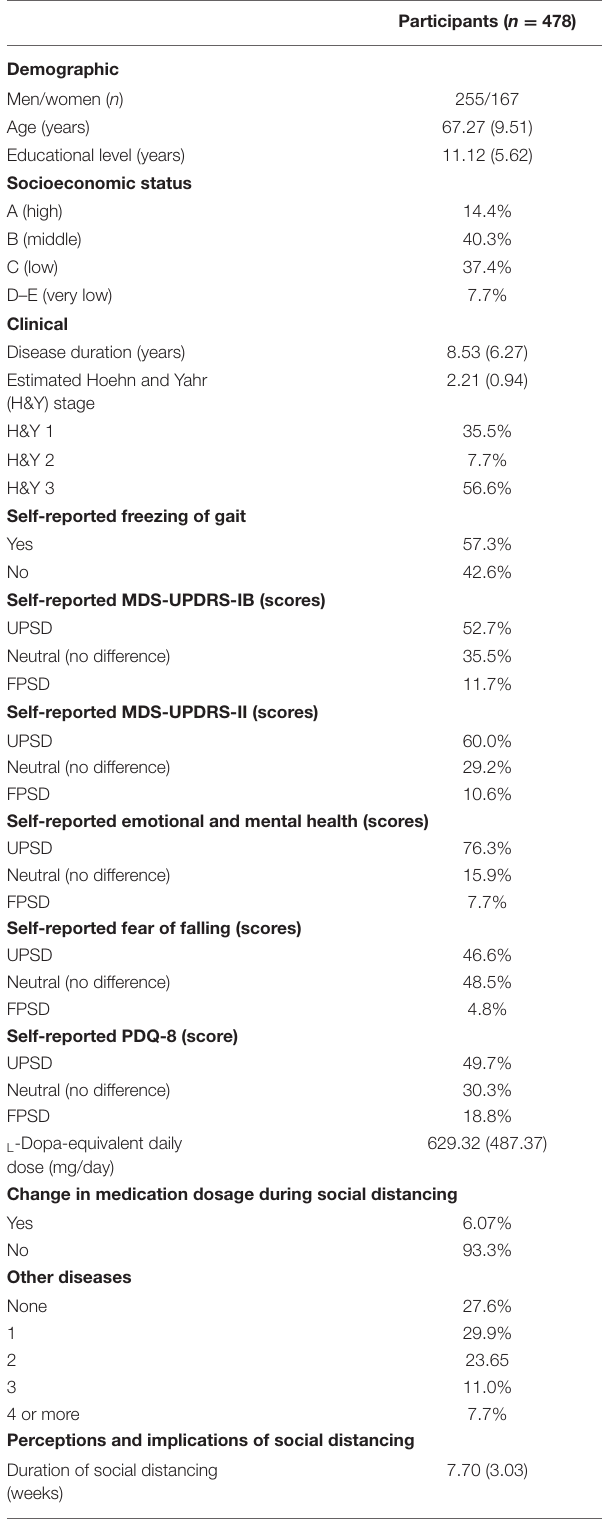
TABLE 1 | Demographic characteristics, socioeconomic status, clinical perception, and perceptions and implications of social distancing due to COVID-19 pandemic of the participants (mean,